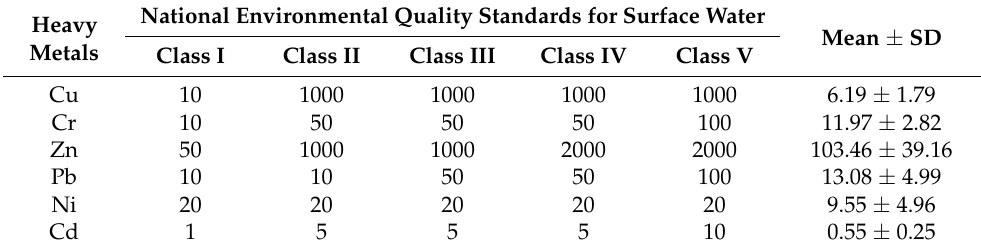
Table 2. Comparison between concentrations of heavy metals in snow cover from Qixing River wetland and environmental quality standards for surface water ( µ g L − 1 ).